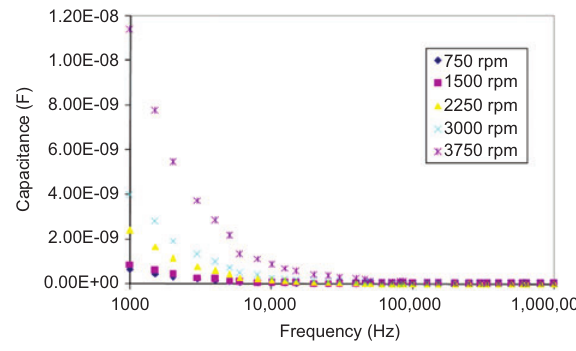
Figure 2 Capacitance from 1 kHz to 1 MHz of PVDF compos- ites with 10 wt % Ni on PCB substrates using varying spin coating speeds.